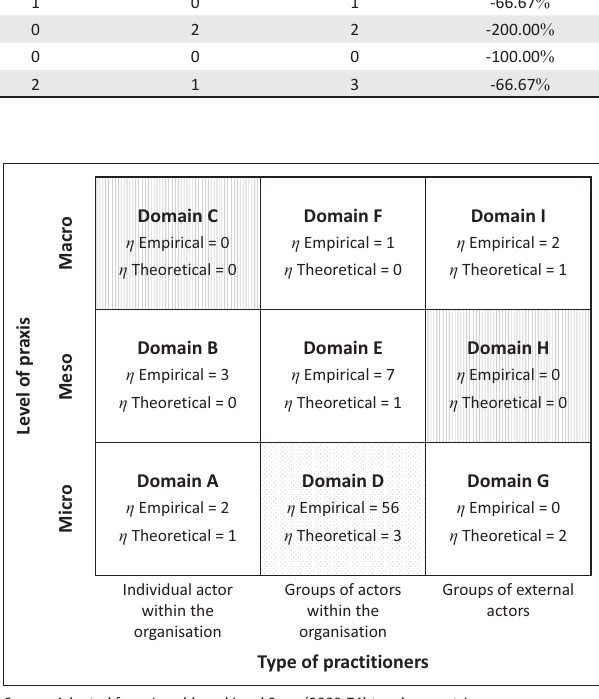
FIGURE 5: 2015 Comparative typology matrix of strategy-as-practice